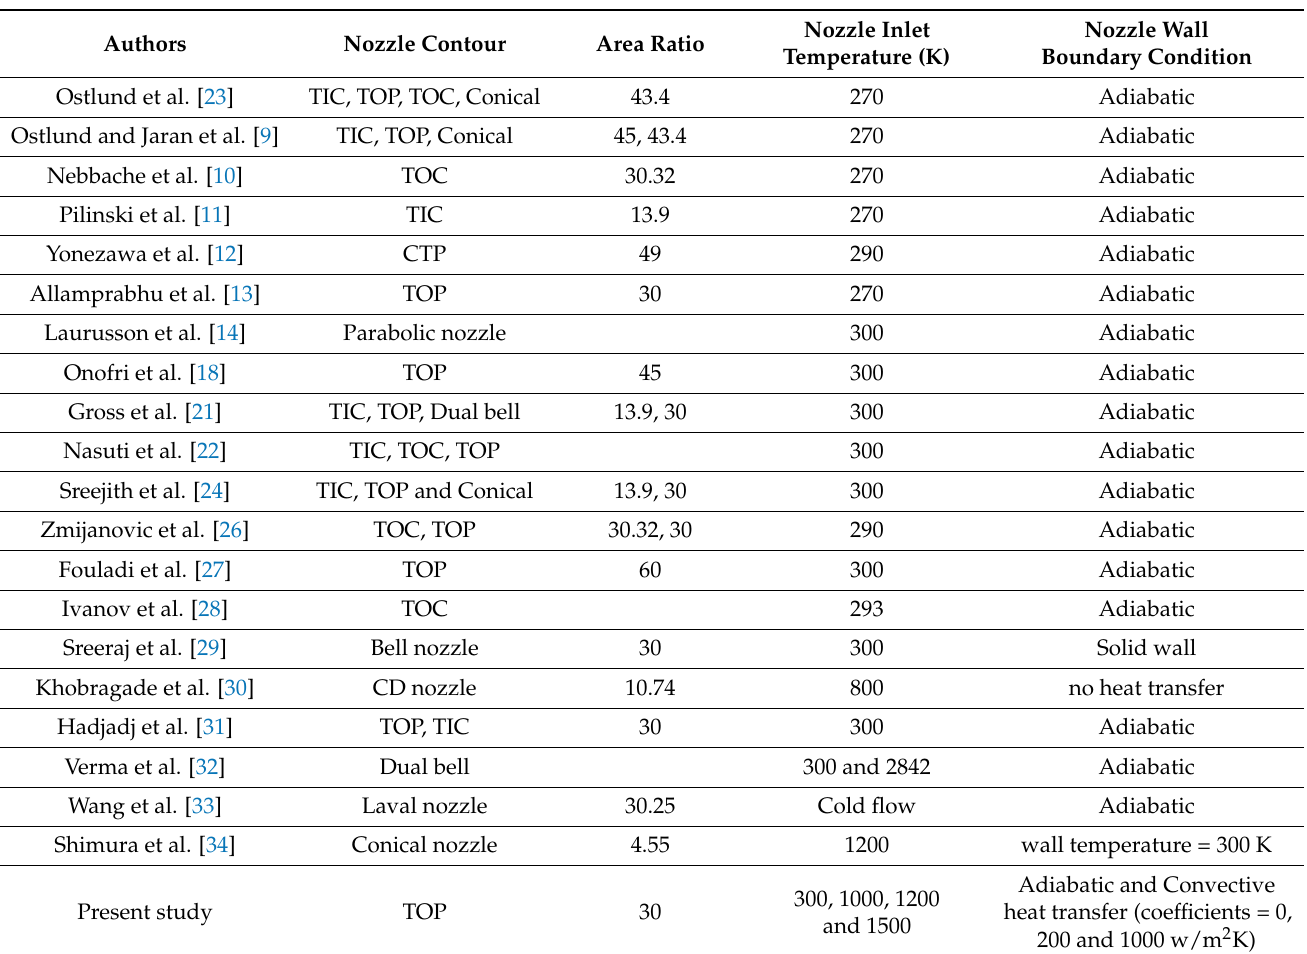
Table 2. Overview of nozzle geometry and boundary conditions considered in the reported literature and the present